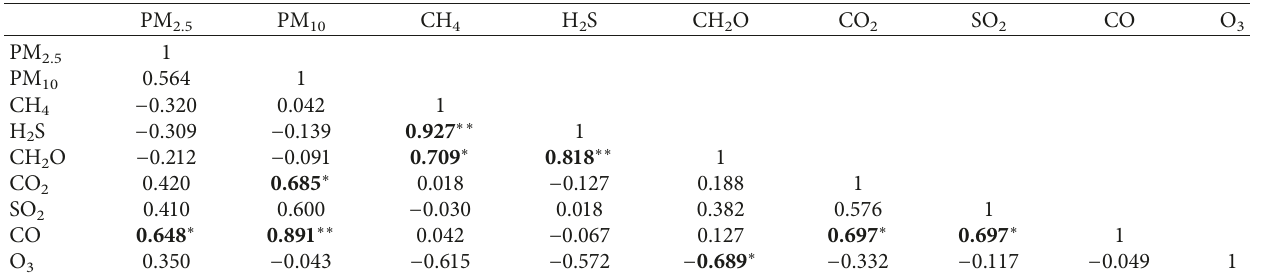
Table 7: Correlation matrix.